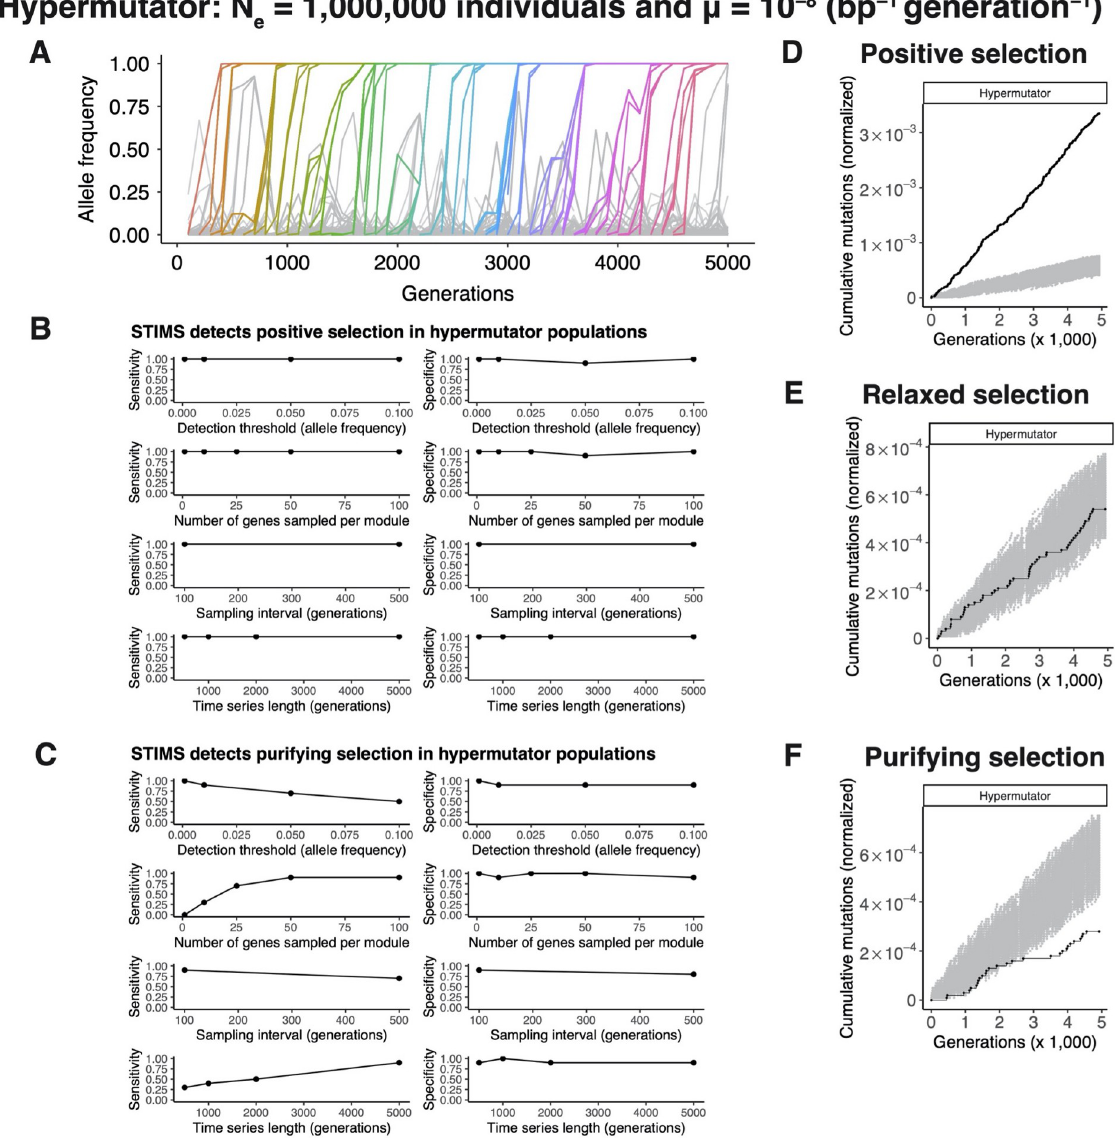
Fig 4. In silico evolution experiments demonstrate that STIMS can detect both positive and purifying selection in hypermutator populations. Bacterial evolution was simulated using a Wright-Fisher model. Each simulation lasted 5,000 generations. The effective population size was set to 1 million individuals. Hypermutator bacteria were modeled using a mutation rate of 10 − 8 per base-pair per generation. Each individual contains an idealized genome of 4,000 genes, each 1,000 base-pairs in length, for a genome of 4 million base- pairs. 100 genes are targets of positive selection, 100 genes are evolving completely neutrally (relaxed selection), and 100 genes are evolving under purifying selection. The remaining 3,700 genes evolve nearly neutrally, based on published estimates of the genomic distribution of mutation fitness effects in Escherichia coli . See the Materials and Methods for further details. A) Typical allele frequency dynamics of a hypermutator population, showing selective sweeps and clonal interference. B) STIMS shows high sensitivity and specificity for detecting positive selection in hypermutator populations. C) STIMS detects purifying selection with increasing sensitivity at lower allele frequency mutation detection thresholds, more genes sampled from the set of genes evolving under purifying selection, the length of the time series, and shorter intervals between metagenomic sampling, and shows high specificity across all tested parameters. D) Typical result of running STIMS on genes evolving under positive selection in the hypermutator simulations. E) Typical result of running STIMS on genes evolving neutrally in the hypermutator simulations. F) Typical result of running STIMS on genes evolving under purifying selection in the hypermutator simulations.